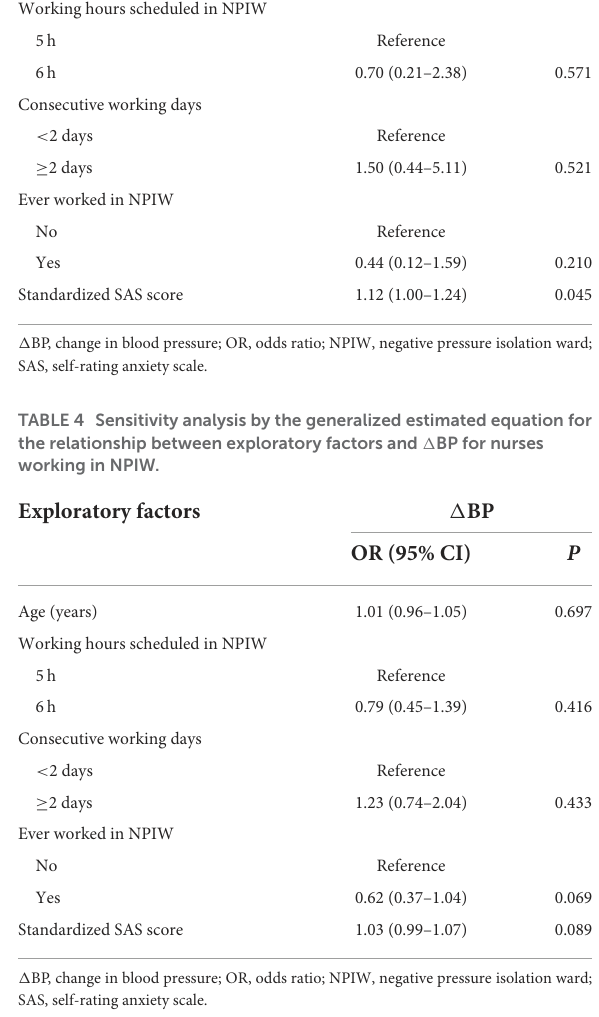
Table 3). Working 6 h/day (vs. 5 h/day) in NPIW was non- significantly related with decreased risk of high 1 BP (OR =